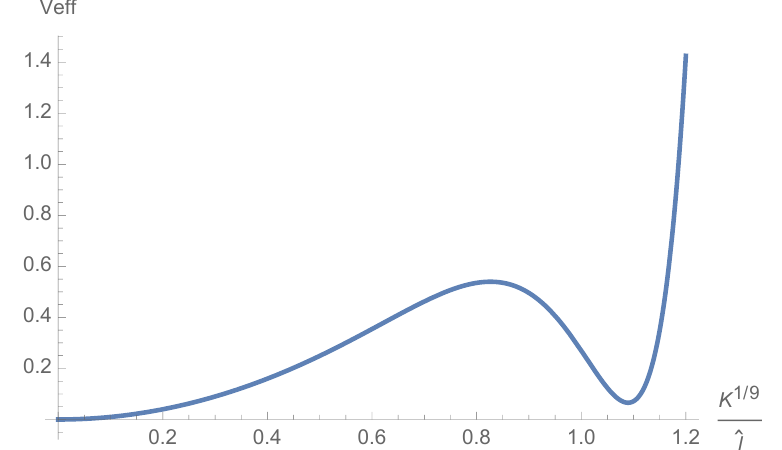
Figure 3: Effective potential with 3-term structure from (2.3). The intermediate negative Casimir contribution balances against curvature (dominant at small 1 / ˆ (cid:96) ), and flux. This produces a dS minimum according to the averaged effects of our stress energy sources, We will incorporate inhomogeneities and warping effects in later sections and find that this volume-stabilization structure persists, with a strong localized Casimir source and controllably small shifts in the bulk